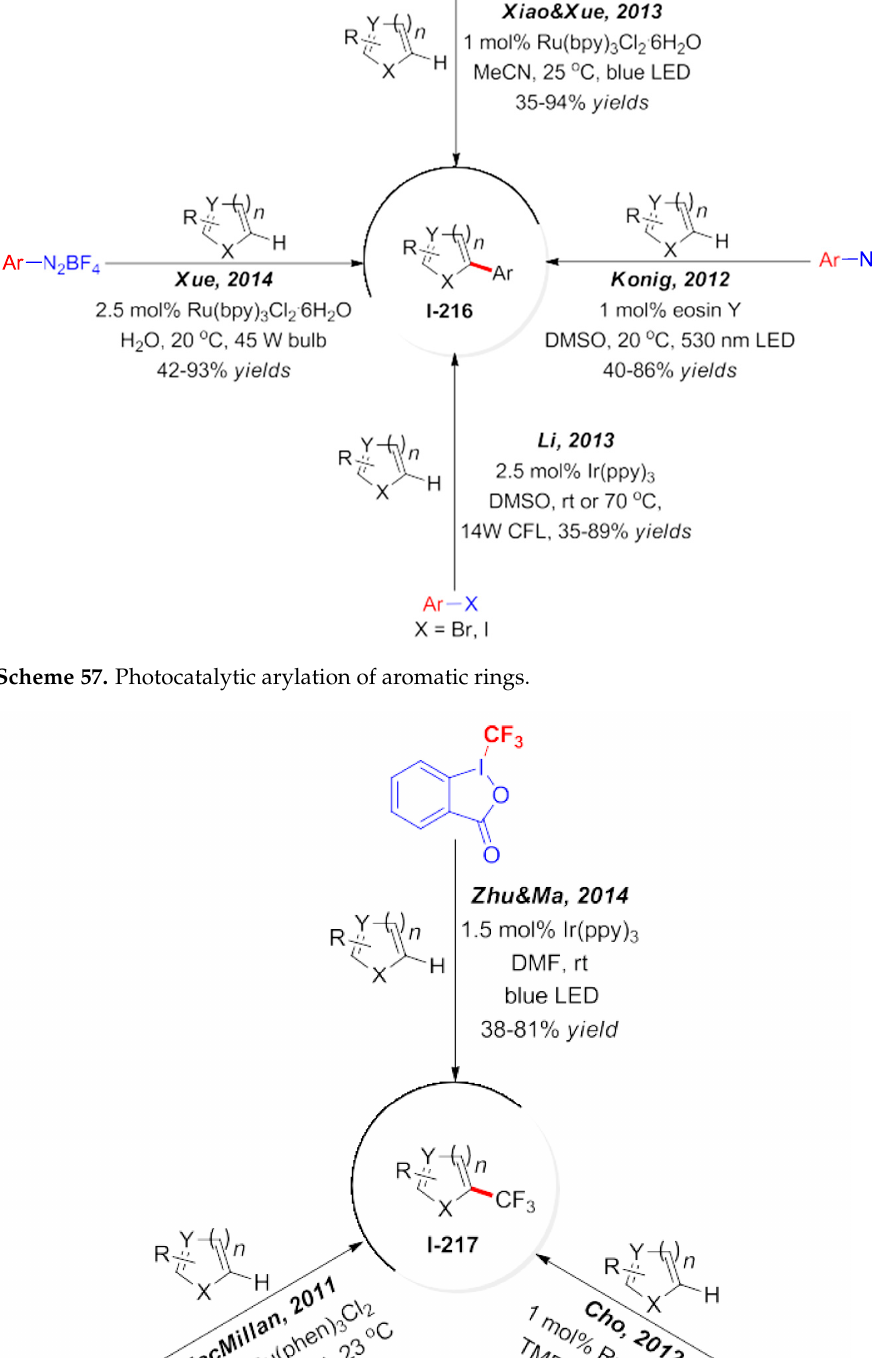
difluorobromomethylamide for the difluoromethylation of aromatic compounds [164]. The Wang group reported the use of iododifluoromethylsulfonic acid with good results [165]. The Cho group used ethyl difluorobromoacetate as a fluorine-containing agent as a radical source and completed a series of difluoroalkylation reactions of aromatic com- pounds [166]. Scheme 59. Difluoromethyl radicals applied to photocatalytic aromatic functionalizations. In addition, there are relevant literature reports on the amination of heterocyclic com- pounds catalyzed by visible light. Nitrogen-containing compounds are used as nitrogen- containing radical sources, such as phthalimide compounds and their derivatives [167,168]. In addition to the above aromatic compounds, other π − system compounds, such as carbon–carbon double and triple bond compounds, are also widely used in the study of photoredox reactions. In this research field, Yasu et al. [169–173] and Iqbal et al.